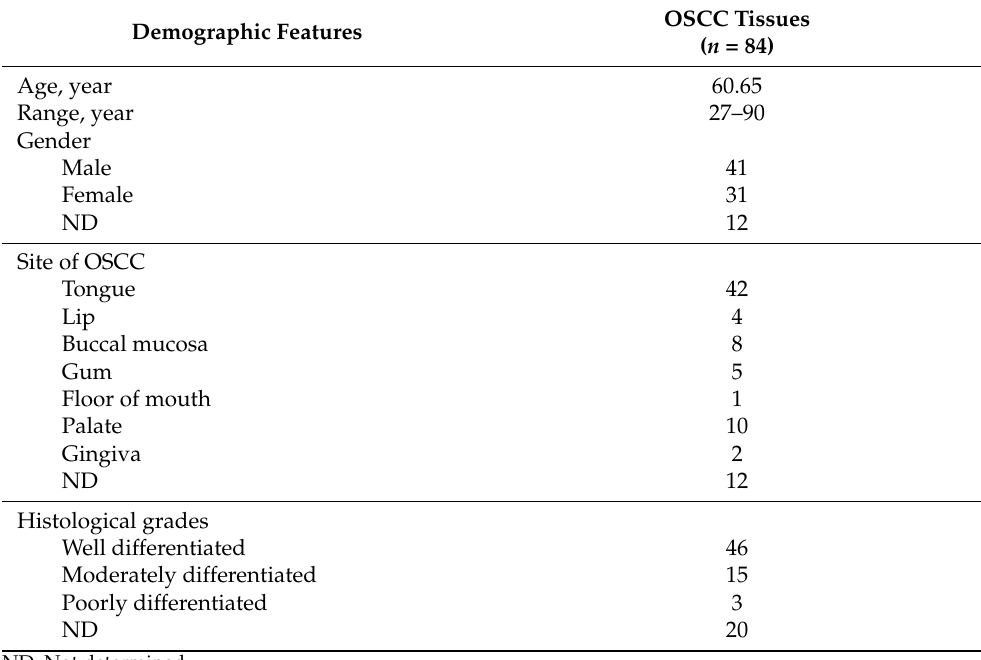
Table 2. Demographic characteristics of OSCC